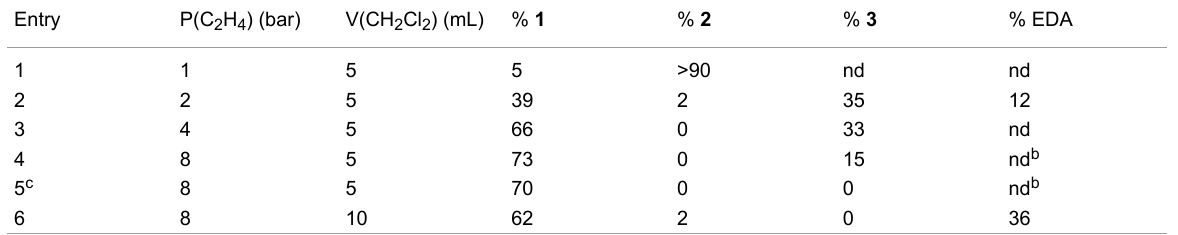
Table 2: Catalytic activity of IPrAuCl/NaBAr F 4 in the reaction of ethylene and ethyl diazoacetate. a